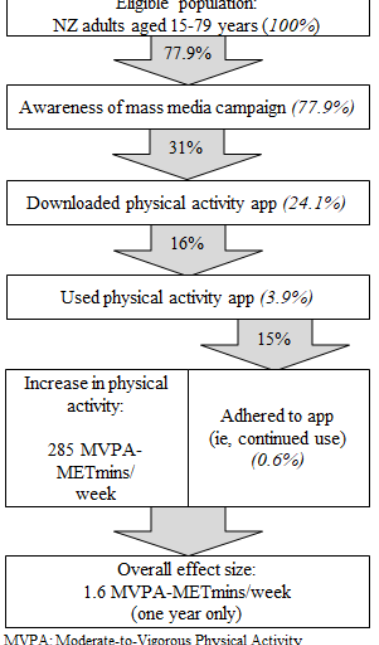
Figure 1. Flow chart of intervention conceptualization. Italicized text represents the percentage of the eligible population exposed to each step in the intervention pathway. NZ: New Zealand.